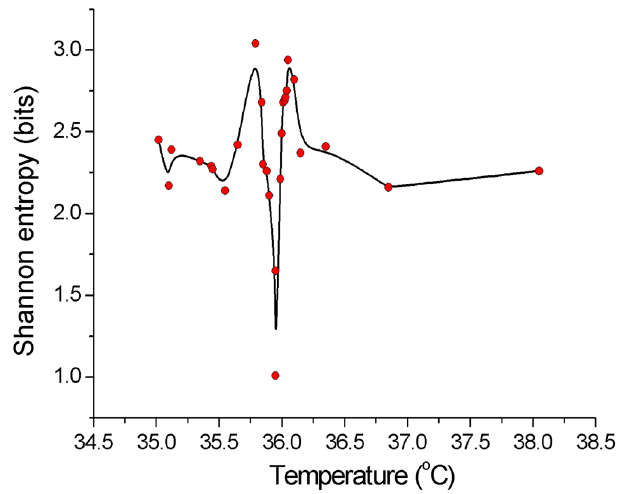
Figure 4. Dynamic Shannon entropy as a function of temperature in a binary representation. Calculated data points (red) were interpolated by B-spline. Note that the lowest value that was obtained at T c corresponds to one